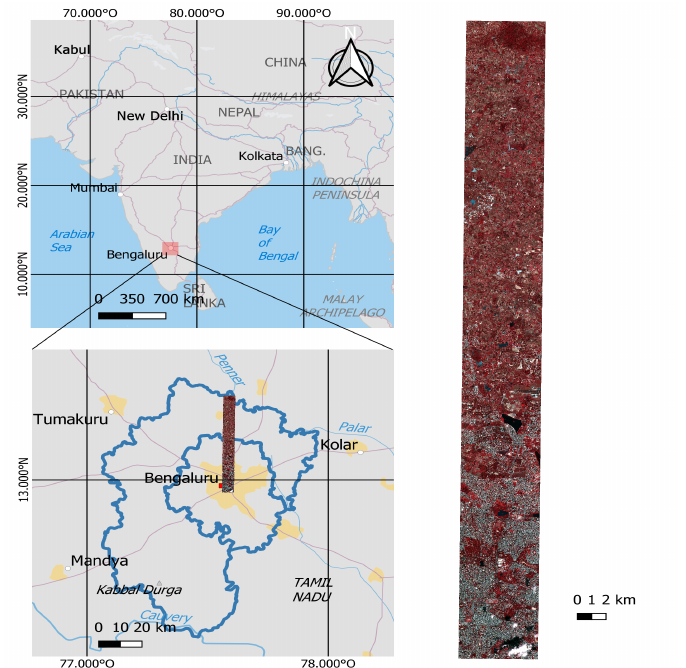
Figure 1. Location of the study area: a transect of 50 km × 5 km in the northern part of Bengaluru, India. The transect is enlarged here as a WorldView-3 false color composite (i.e., near IR1, red and